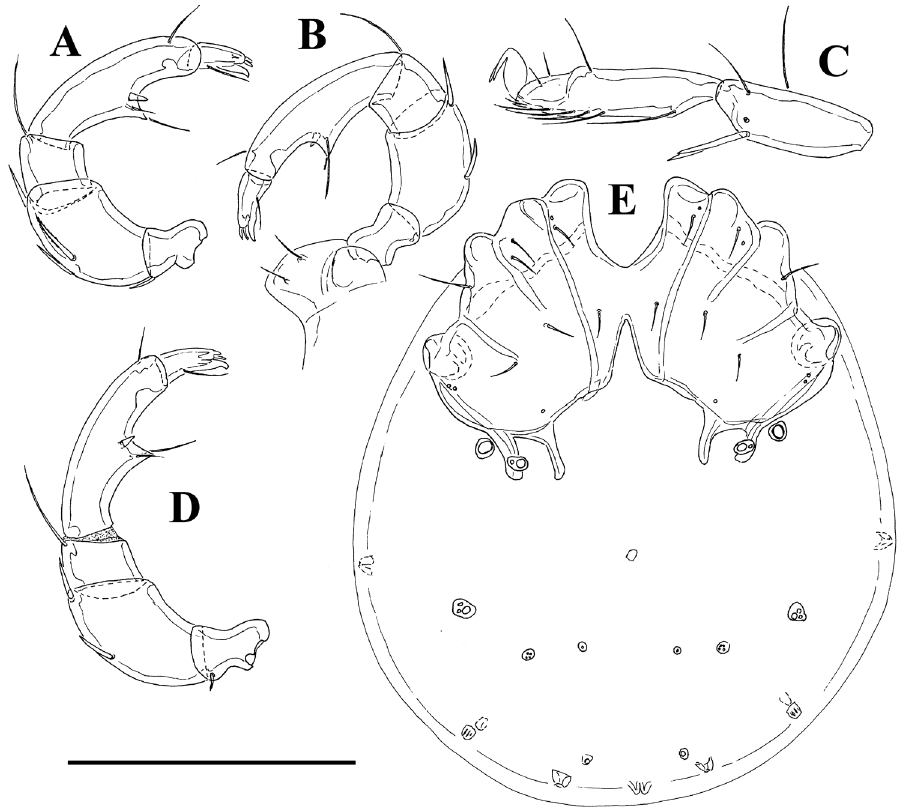
Figure 3. Litarachna lopezae sp. n., Bajo de Sico (A-C = male, D = female, E = deutonymph): A–B, D